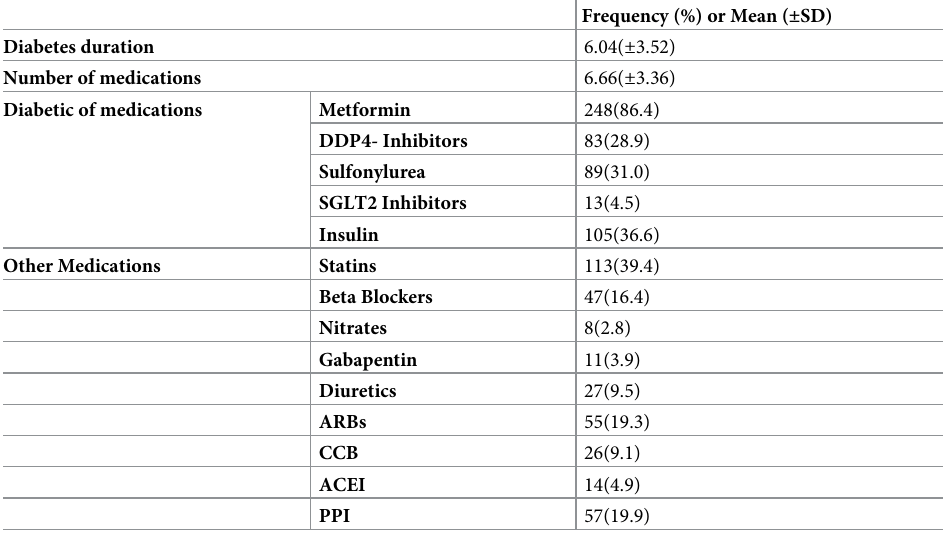
Table 2. Disease and medications characteristics of the participants.